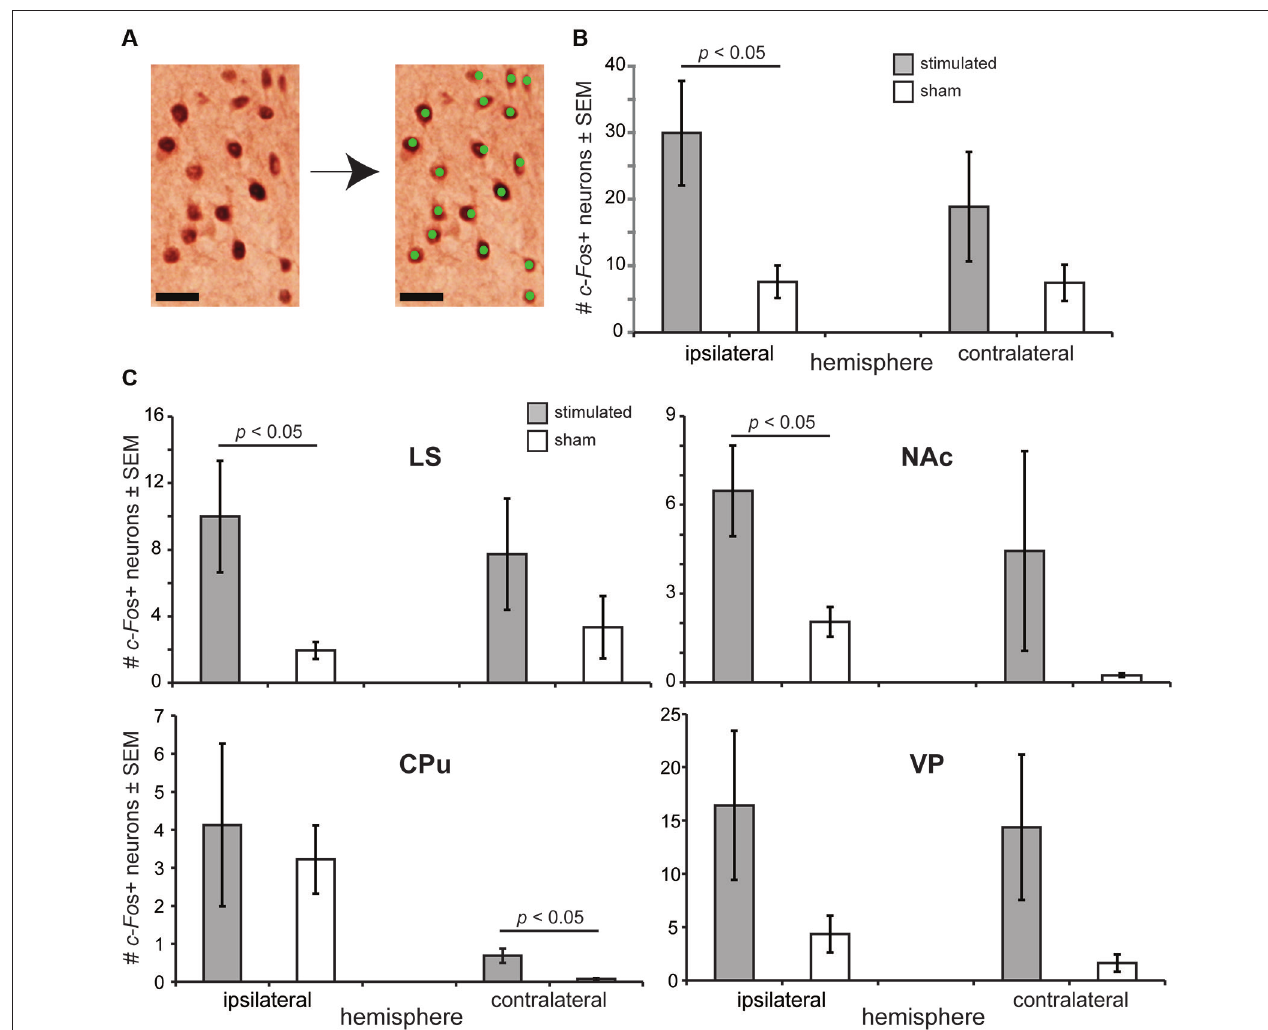
200 µ m 2 bounding box. (C) Effects of OT stimulation on the number of c-Fos + neurons in forebrain reward and motivated behavior centers, including the NAc (nucleus accumbens), CPu (caudate putamen), LS (lateral septum), and VP (ventral pallidum). n = 13 mice stimulated, 8 mice sham for all structures, ≥ 5 sections/structure. c-Fos + neuron counts were quantified within a 200 µ m 2 bounding box. p -values = ANOVA followed by Fisher’s